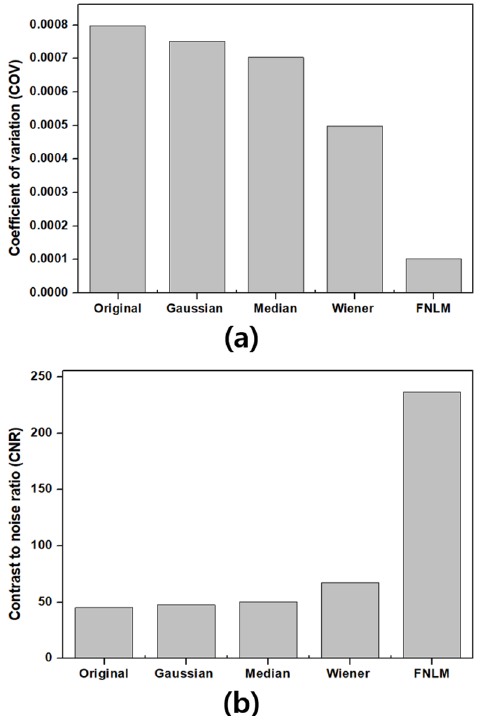
Figure 7. The ( a ) coefficient of variation (COV) and ( b ) contrast-to noise-ratio (CNR) metrics computed in the set ROIs to evaluate the noise level of the reconstructed image obtained from the 5- year-old phantom.